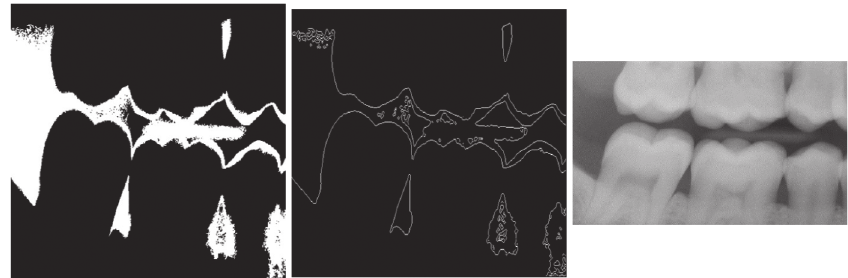
Figure 5: Left: region growing approach; central: canny edge detected image; right: tooth isolation and gap valley using binary intensity integral curves [38].